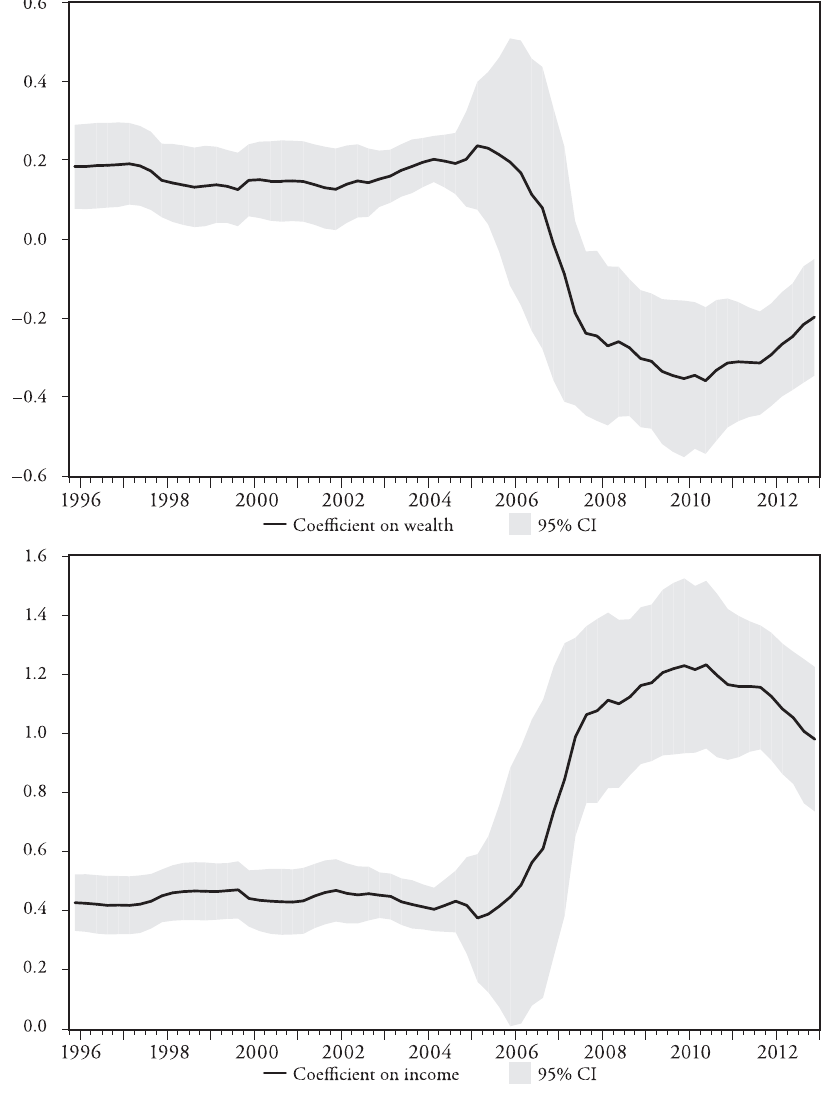
Figure 8: Rolling Estimation Results for the Cointegration